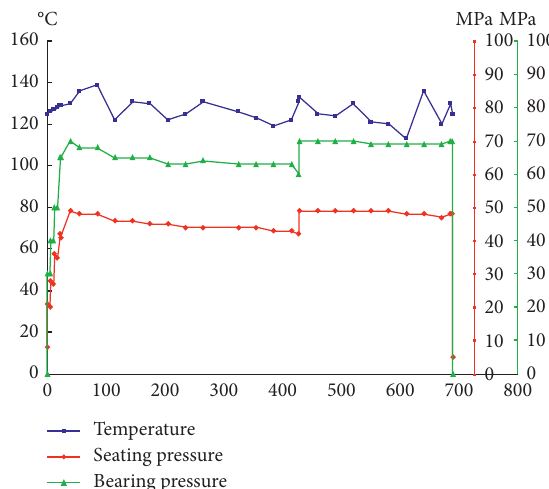
Figure 27: Change curve temperature, seating pressure, and bearing